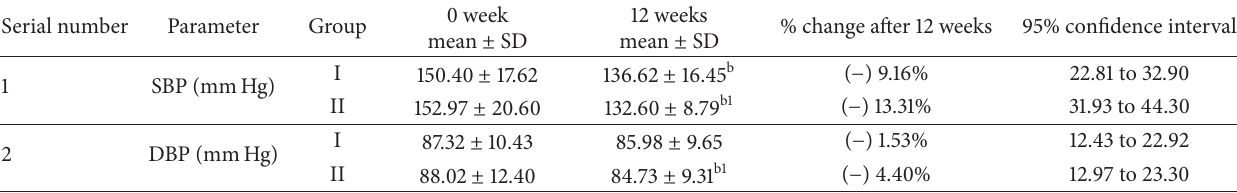
Table 1: Blood pressure in control and Rhubarb groups before and after 12 weeks of treatment.